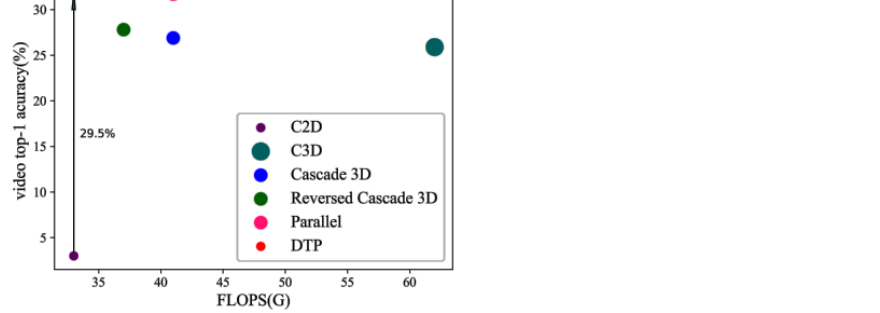
Figure 6. Accuracy vs. computational cost for various structures, and the size of dots denotes the amount of